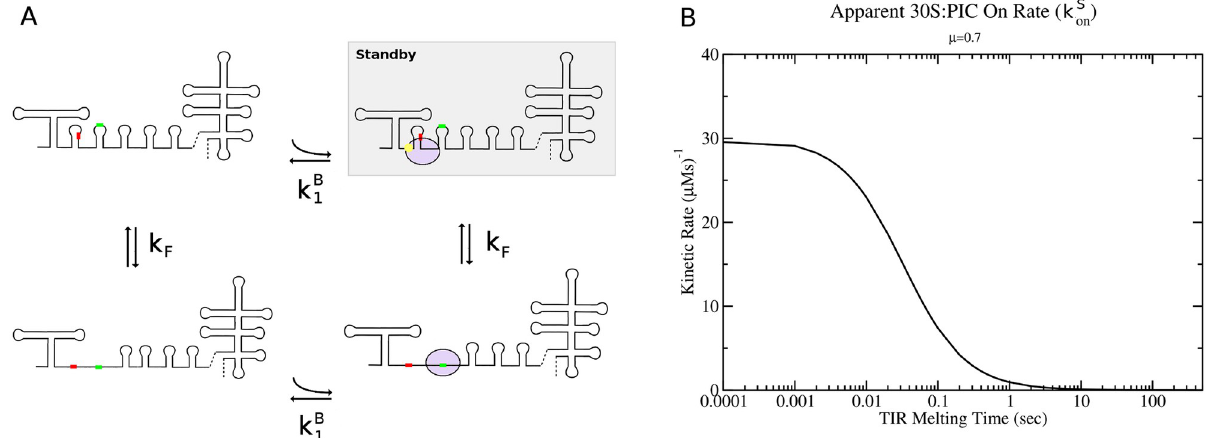
Fig 3. Model of ribosome binding kinetics to a translation initiation region. (A) Kinetic model of 30S:PIC binding to a TIR region of an mRNA via standby and direct pathways. TIR regions are considered as being hairpin only regions, possibly flanked by multi-loop helices. k − F = 1/ τ u is the kinetic rate of TIR unfolding, while k B is the binding rate of 30S:PIC to the mRNA via ribosome protein S1. (B) Apparent 30S:PIC binding rate to TIR region at 1 a cellular growth rate of μ = 0.7 doublings per hour.